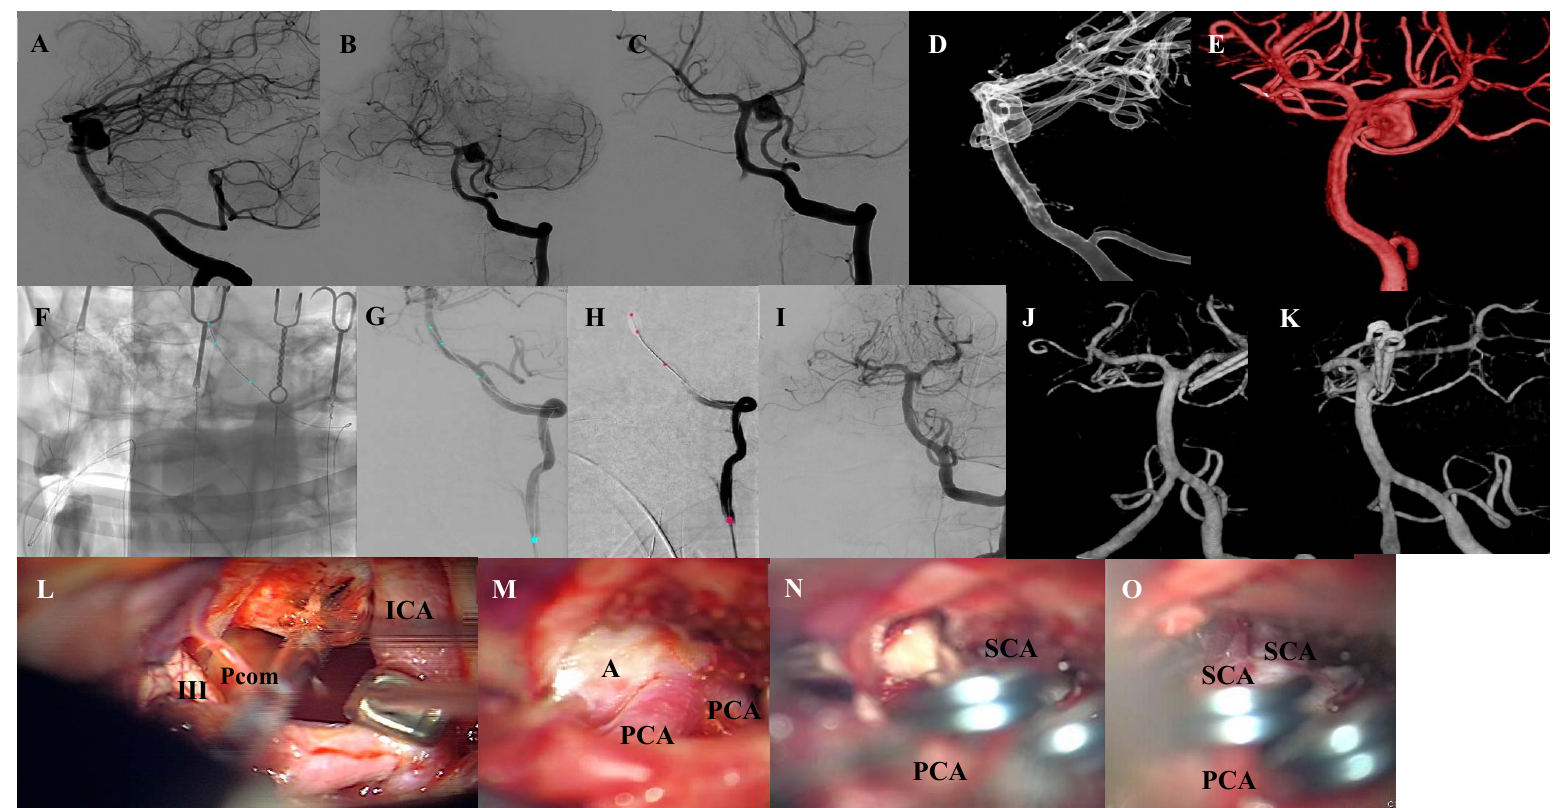
Figure 2. Case 2. Preoperative DSA ap and lateral projections of the left side dissecting basilar artery aneurysm ( A – C ). Preoperative 3D ‐ DSA of the basilar aneurysm, presenting the ampullary exit of the left double ‐ laid SCA from the aneurysm fundus ( D , E ). Intraoperative DSA showing the endovascular placement of the balloon and occlusion of the basilar artery through balloon inflation ( F , G ). Intraoperative angiography after clipping and deflation of the balloon demonstrating occlusion of the aneurysm in the ap and lateral view ( H , I ). Intraoperative 3D angiography in the ap and lateral view, showing a small remnant at the neck of the aneurysm to preserve the SCA exit ( J ). Microsurgical view showing the aneurysm approach with mobilization of the ICA with hook retractor ( K ), BA aneurysm ( L ), and situs after clipping with patency of all branches and parent vessel ( M – O ). Abbreviations: DSA = digital subtraction angiography, SCA = superior cerebellar artery, ICA= internal carotid artery, BA= basilar artery, III = oculomotor nerve, PCA = posterior cerebral artery, A = aneurysm, Pcom = posterior communicating artery.